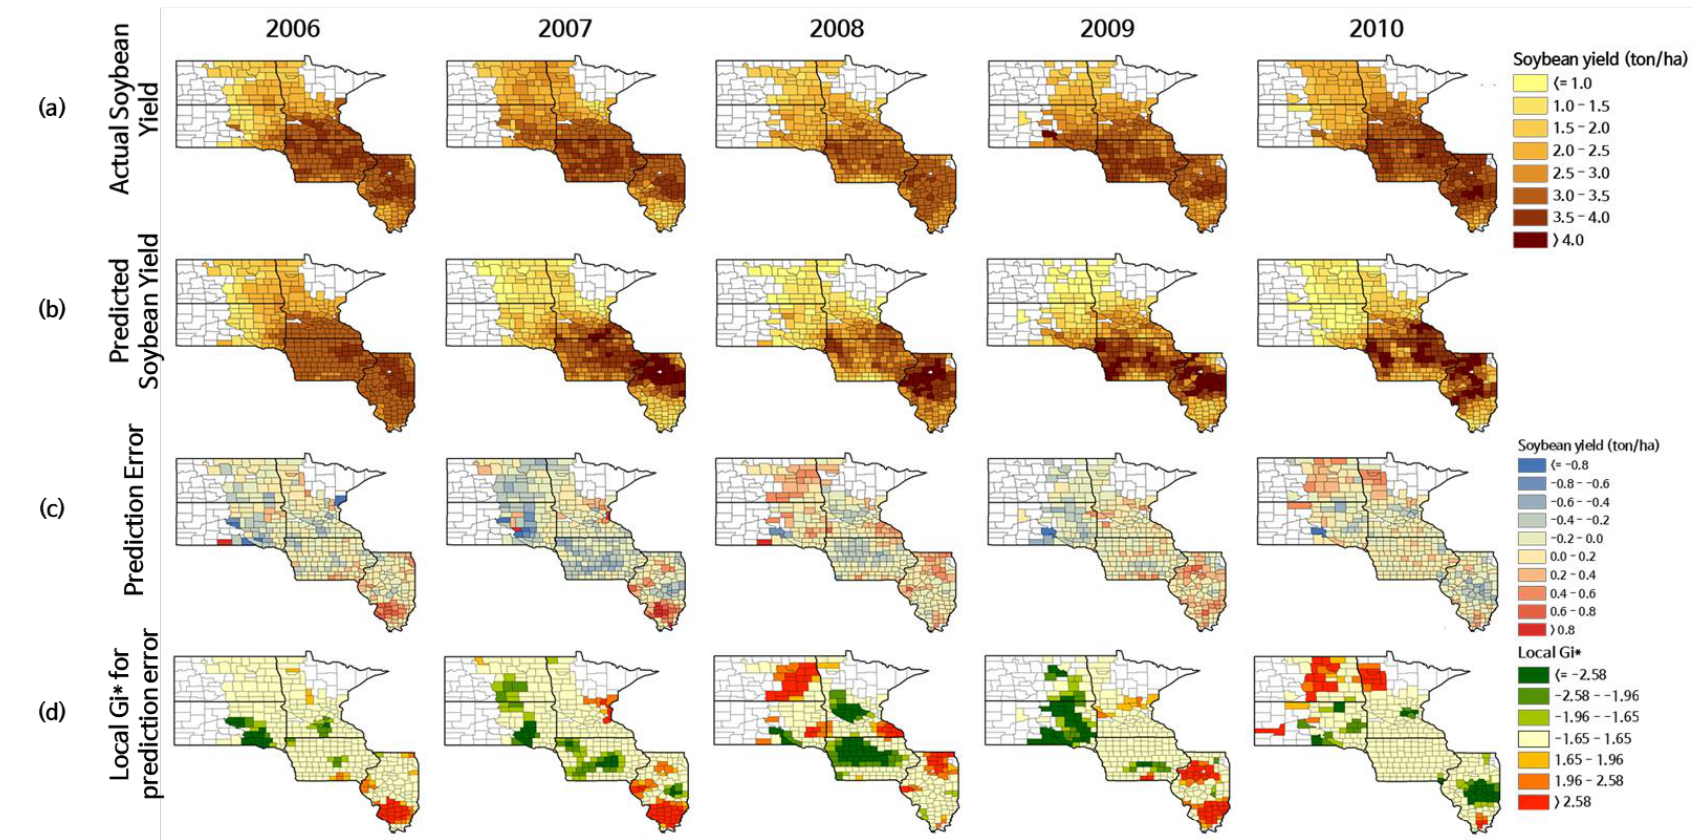
Figure 9. Maps of the actual and predicted soybean yields, prediction errors, and Local Geary index (Gi*) of the prediction errors, 2006 – 2010.